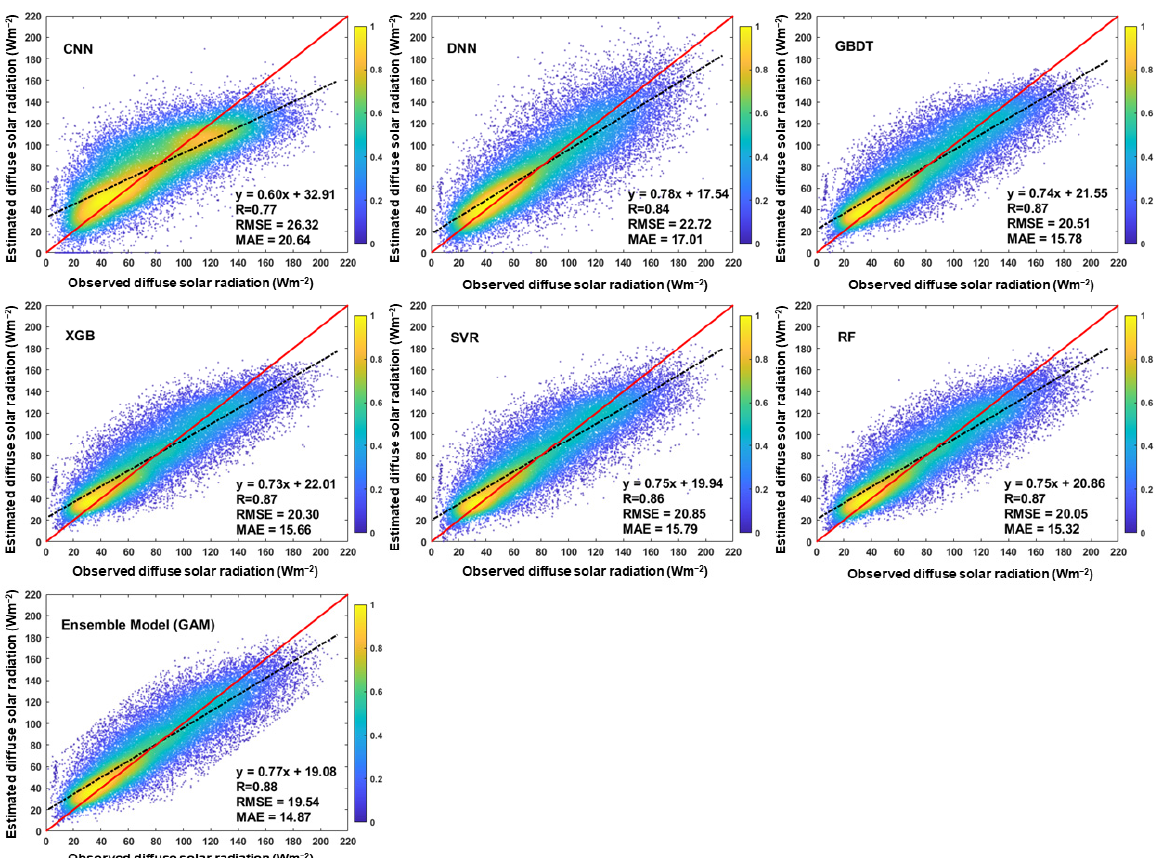
Figure 3. Density scatterplots of sample-based cross-validation results for six base ML models and an ensemble model. The red solid line is the 1:1 line. The black dashed line is the best-fit line from linear regression. Table 3. Cross-validation for ensemble model (GAM) at different